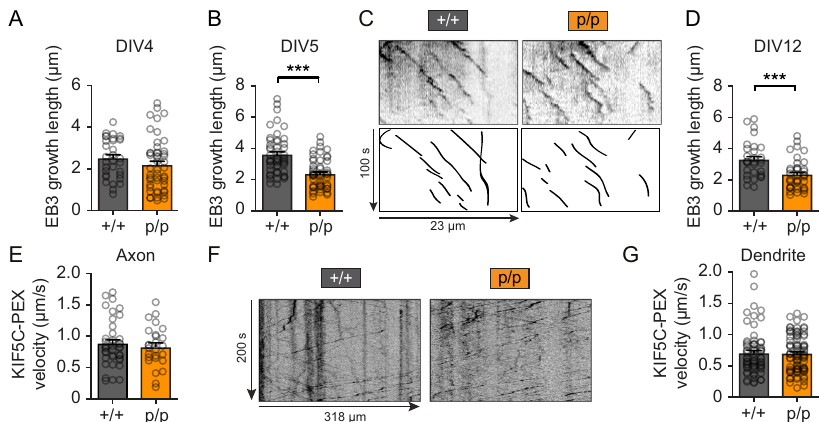
Fig. 3 Loss of Tuba4a C-terminal polyglutamylation alters microtubule growth without affecting kinesin motor protein processivity. A – D Live imaging of EB3-GFP in hippocampal neurons derived from Tuba4a Δ polyGlu ( + / + ) and (p/p) mice. Quanti fi cation of EB3-GFP growth length 24 h after transfection at DIV4 ( A ), DIV5 ( B ) and DIV12 ( D ). Representative kymographs acquired from dendrites at DIV5 are shown in ( C ). Upper panels: GFP signal, lower panels: tracked EB3-GFP. Analyzed comets from 19 to 24 cells from three independent cultures per genotype per DIV: DIV4, n ( + / + ) = 32, n (p/p) = 48; DIV5, n ( + / + ) = 49, n (p/p) = 53; DIV12, n( + / + ) = 30, n (p/p) = 40. E – G Quanti fi cation of KIF5C motility (velocity in µ m/s) in axons ( E ) and dendrites ( G ) at DIV13 using KIF5C without a cargo-binding domain fused to tdTomato and pex26 (peroxisome binding domain) expressed for 24 h in hippocampal neurons derived from Tuba4a Δ polyGlu ( + / + ) and (p/p) mice. Representative kymographs of KIF5C in dendrites are shown in ( F ). Analyzed tracks from 17 to 23 cells from three independent cultures per genotype: Axon, n ( + / + ) = 40, n (p/p) = 26; Dendrite, n ( + / + ) = 68, n (p/p) = 89. Two-sided Mann – Whitney test was used to assess statistical signi fi cance. *** p < 0.001. Data represent mean ± SEM. Source data, including exact p -values, are provided as a Source Data fi